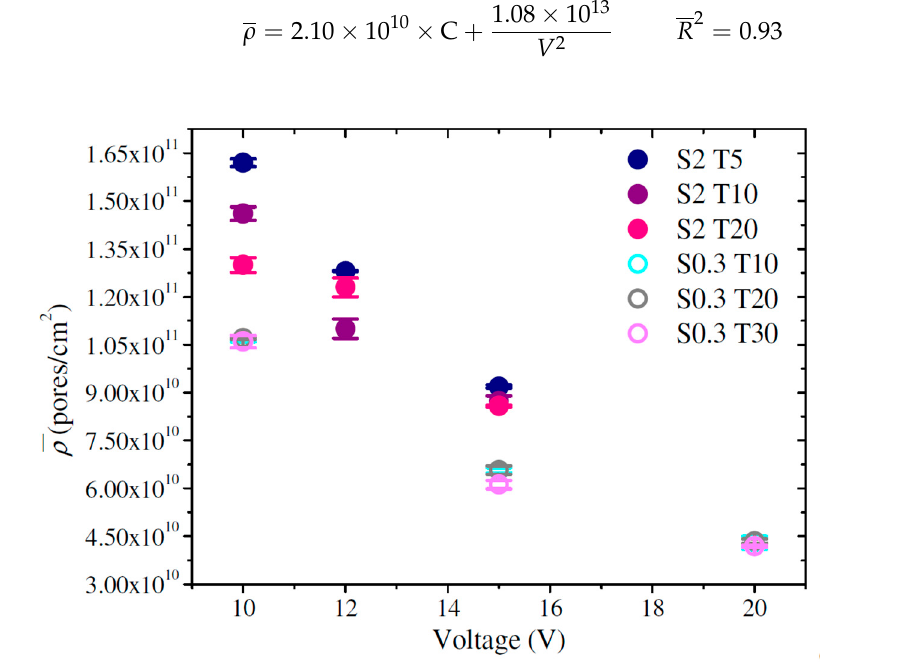
Figure 5. Variation of pore density of nanostructured aluminium oxide films anodized in sulphuric acid as a function of the concentration and temperature of the electrolyte and the voltage.